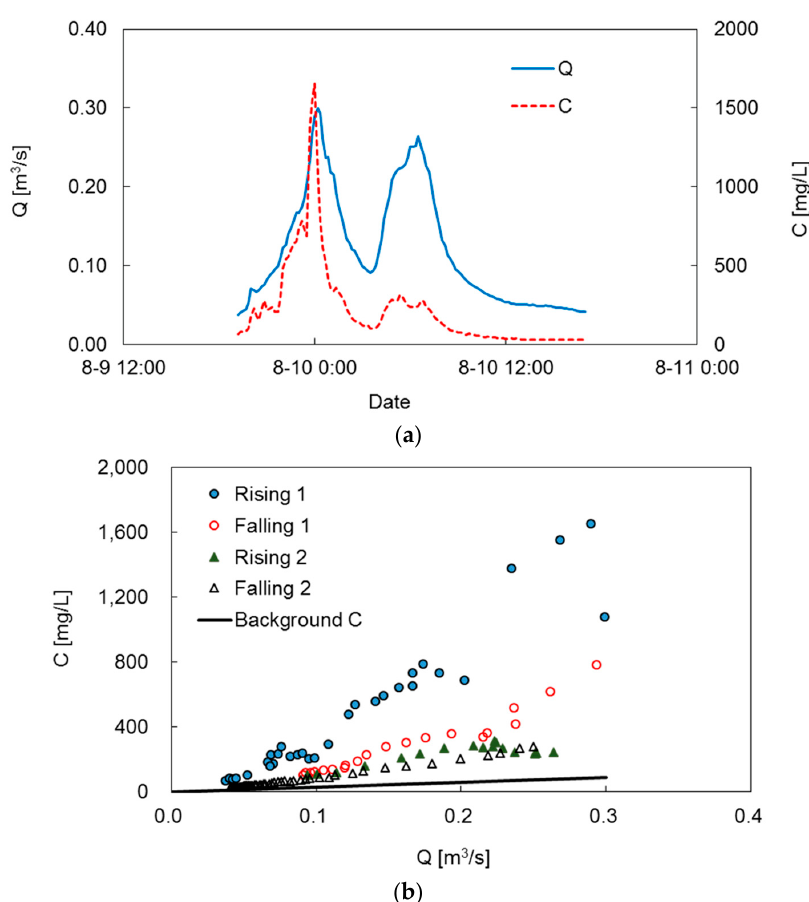
Figure 3. ( a ) Hydrograph (date format: month-day hour:min) and ( b ) hysteresis of sediment concentration (C) to suspended sediment load (Q) for sequential floods in Moulinet between 9 and 10 August 2002.